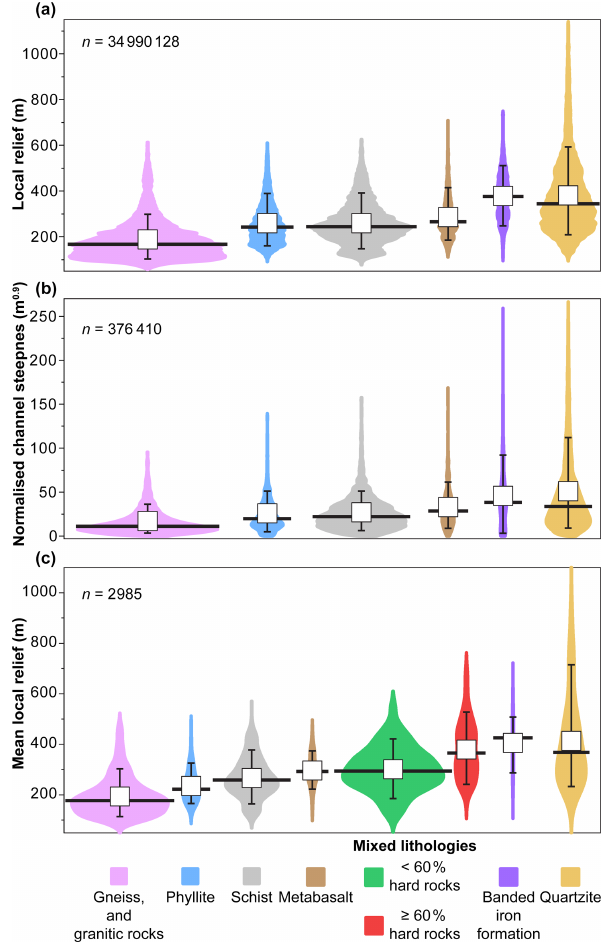
Figure 5. Lithology controls topographic forms in the study area. Violin plots show the probability density (smoothed by a ker- nel density estimator), per rock type, of (a) local relief, (b) nor- malised channel steepness, and (c) catchment-averaged local re- lief. Panels (a) and (b) represent the distribution of local relief and normalised channel steepness for the entire study area, whereas panel (c) shows mean values of local relief for all catchments with a stream order equal or higher than the second order (Strahler, 1957) underlain by the rock types represented in (a) – (c) . Whiskers show the interval between the 10th and 90th percentiles of the data, white squares represent mean values, and thick black lines exhibit median values.